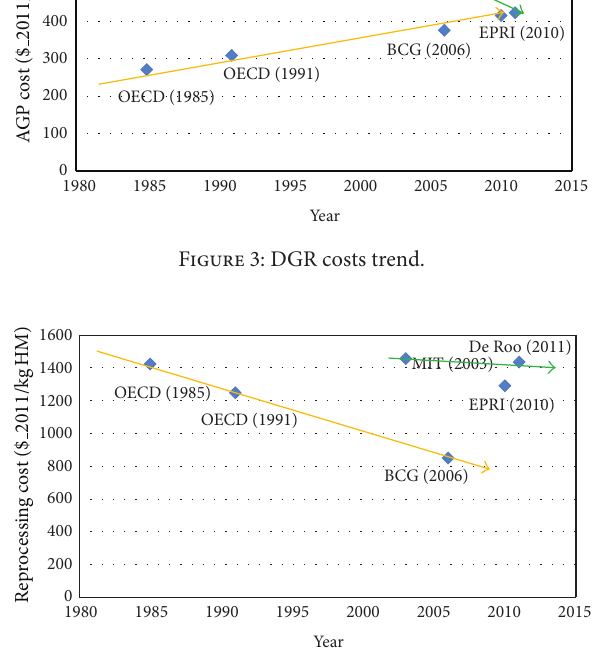
Figure 4: Reprocessing cost trend.